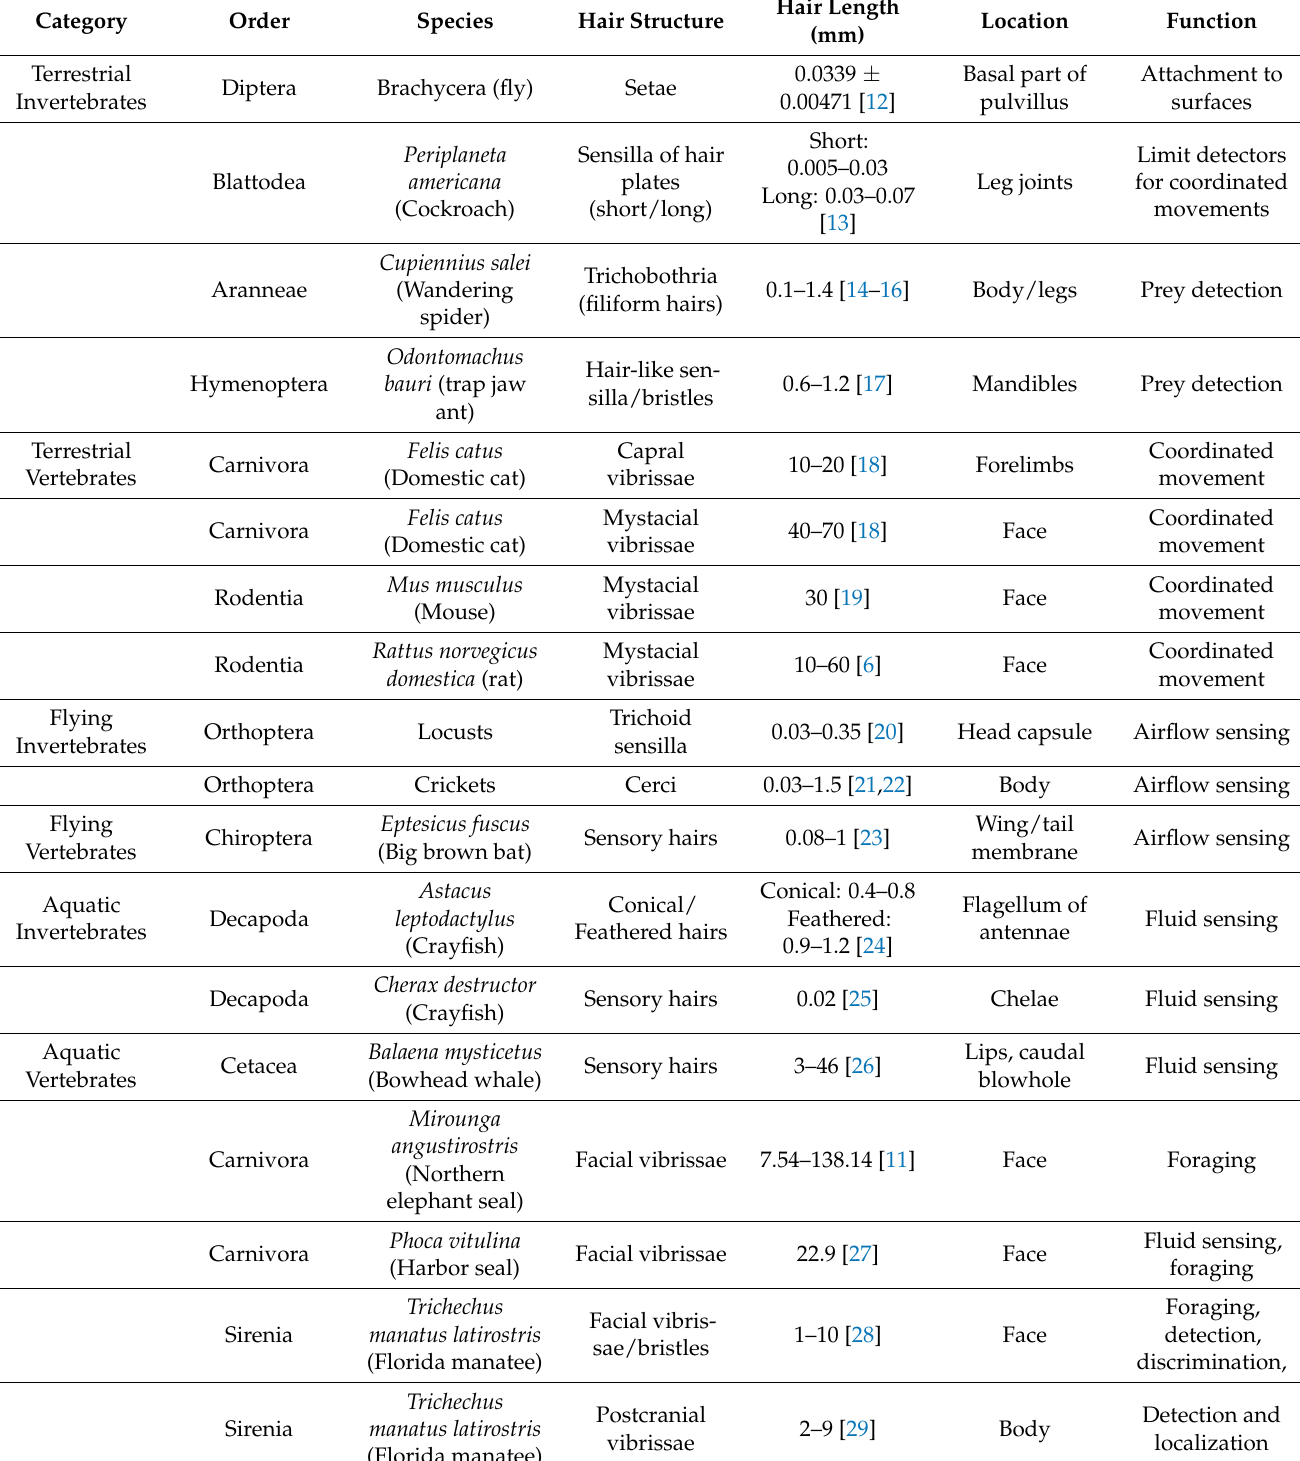
Table 1. Overview of features of hairs and hair-like